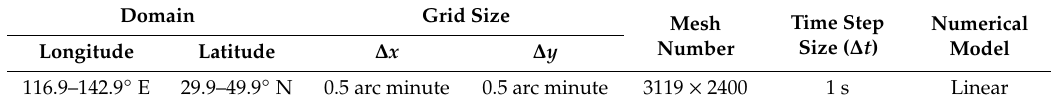
Figure 3. Representative results of numerical modeling with potential tsunami scenarios in Table A1 (Appendix A): ( a ) Case 04: left—initial sea surface displacement (m), right—maximum wave height distribution (m); ( b ) Case 10: left—initial sea surface displacement (m), right—maximum wave height distribution (m); ( c ) Case 30: left—initial sea surface displacement (m), right—maximum wave height distribution (m) [18]. Table 1. Numerical modeling